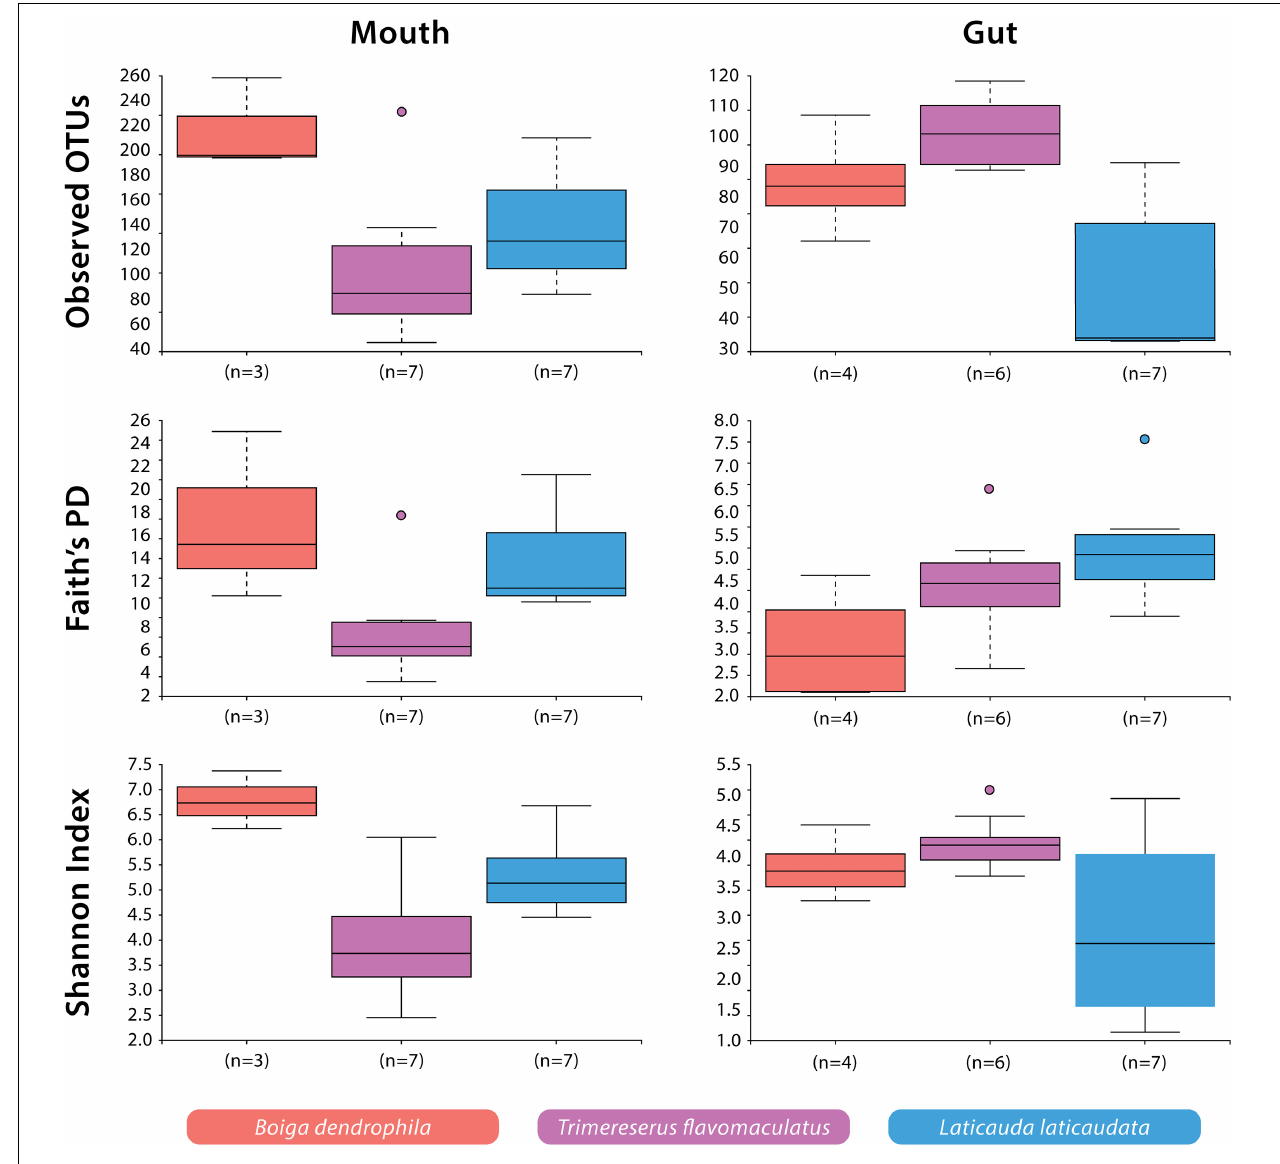
FIGURE 2 | Alpha diversity (Observed OTUs, Faith’s Phylogenetic Diversity, and Shannon Diversity) of bacterial OTUs by host species and body site.